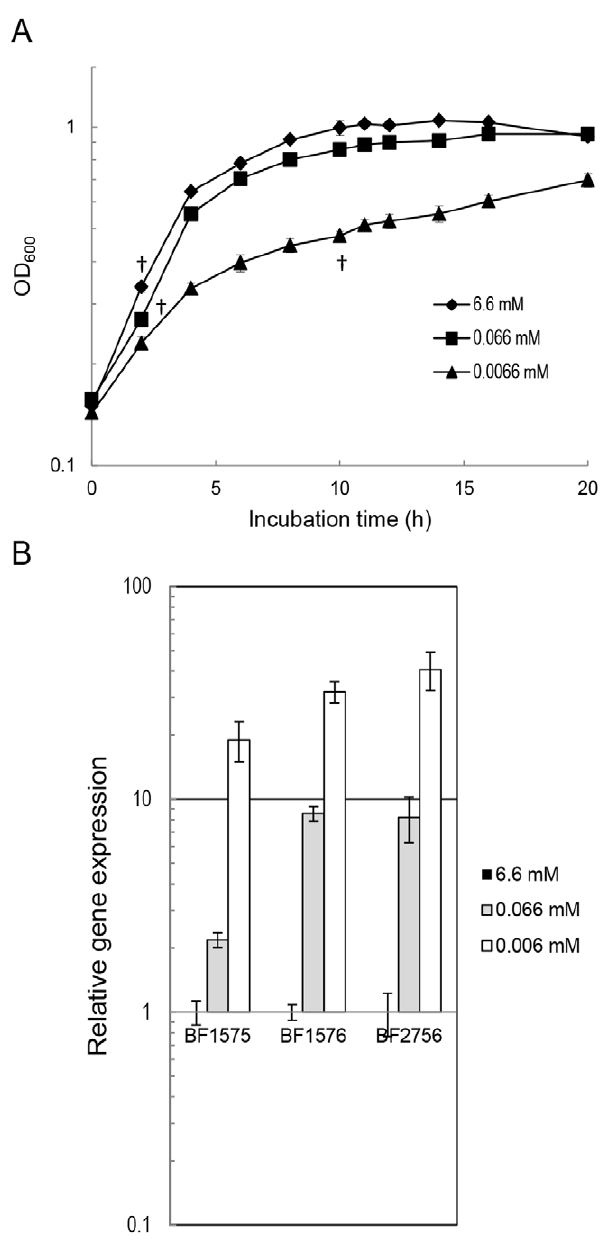
Figure 1. Response of B.fragilis to Pi limitation. (A) Growth curve in DMM supplemented with varying concentrations of KH 2 PO 4 . B. fragilis strain YCH46 was grown anaerobically in DMM supplemented with 6.6 mM, 0.066 mM, or 0.0066 mM of KH 2 PO 4 at 37 u C for 20 h. Optical densities of the cultures at 600 nm were measured over time. Data presented are the mean 6 standard deviations of three independent cultures. (B) qPCR analysis of BF1575, BF1576, and BF2756. Total RNA was collected at mid-logarithmic phase (indicated by { in panel A). Expression levels of BF1575 ( phoR homolog), BF1576 ( phoB homolog), and BF2756 ( pstC homolog) in wild type B. fragilis strain YCH46 were measured and normalized with transcriptional levels of rpoD . The transcriptional level of each gene under Pi limitation (0.066 mM or 0.0066 mM) is shown relative to that in DMM supplemented with 6.6 mM KH 2 PO 4 (Pi-rich